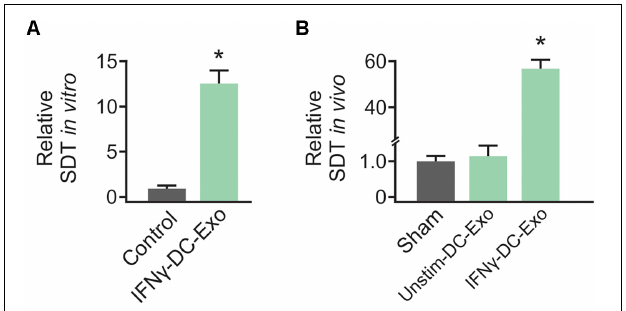
FIGURE 2 | Nasal administration of IFN γ -DC-Exosomes reduces oxidative stress. (A) Nasal administration of IFN γ -DC-Exos significantly reduced expression of the M1 polarization product iNOS by 4.37-fold compared to expression levels in Sham animals. Significance was determined by greater than 2-fold change. Though there was no significant change in other M1 and M2a markers measured, this reduction in iNOS was reflected by a similarly significant ( ∗ p = 0.035) reduction in (B) protein carbonyl content in Sham versus IFN γ -DC-Exo-treated animals. Significance determined by ANOVA plus post hoc Holm-Sidak